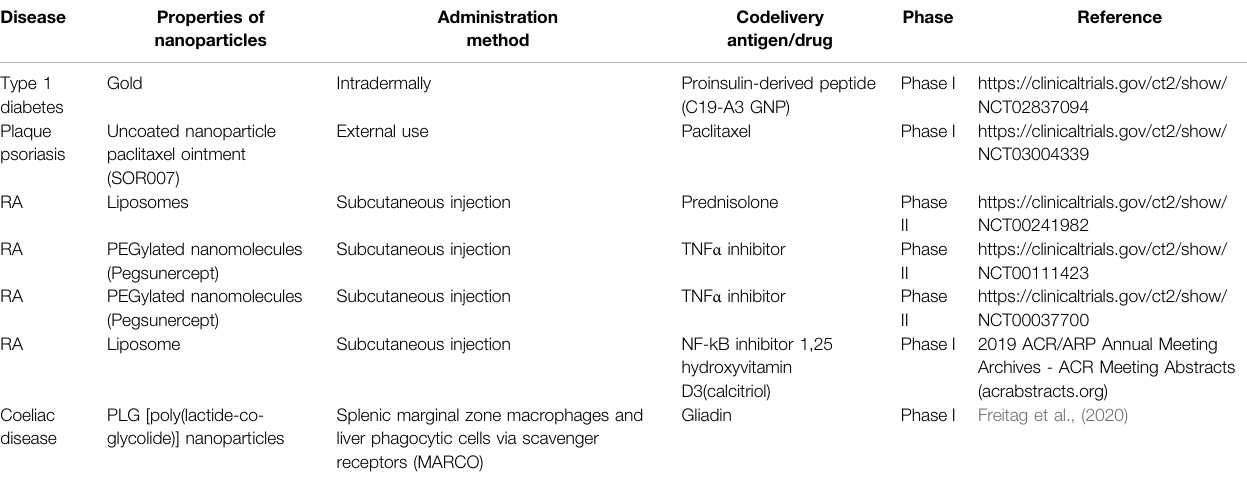
TABLE 1 | Some clinical trials on nanoparticle therapies for tolerance induction. Disease Properties of